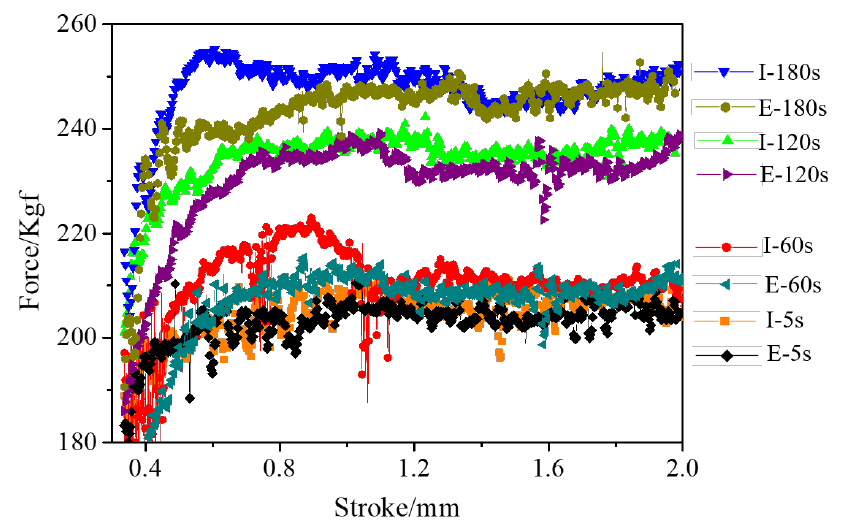
Figure 10. The extrusion force of different carburized layer thicknesses (I-5s, I-60s, I-120s, I-180s) and the extrusion force of carburized layers of the same thickness (E-5s, E-60s, E-120s, E-180s).